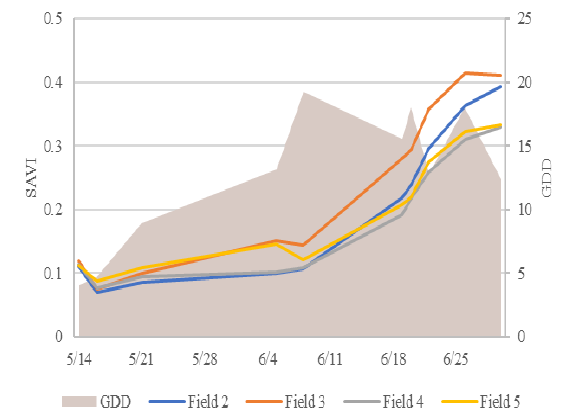
Figure 9. The variation of SAVI and GDD for the 2017 range of critical growth weeks (6 to 13)